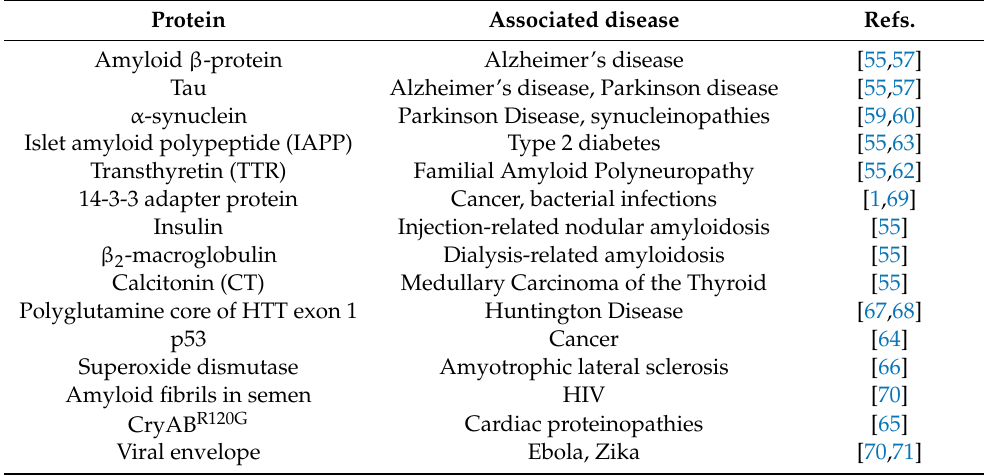
Table 2. Amyloidogenic proteins inhibited by CLR01 and their associated diseases. Protein Associated